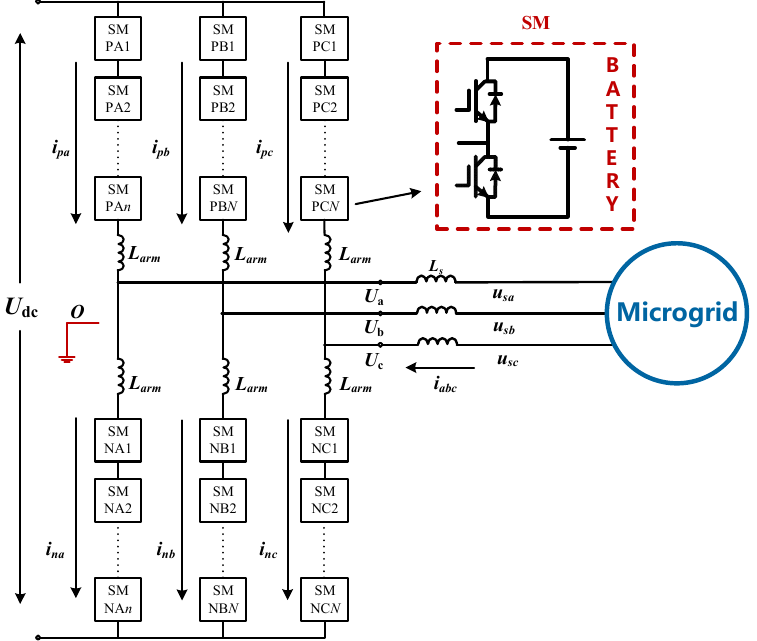
Figure 1. Topology of an MMC-BESS and application scene.